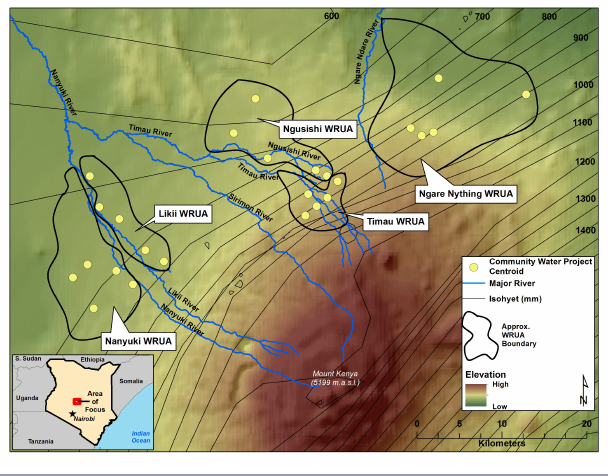
Fig. 1. Study area. Note: WRUA boundaries have been approximated. CWP locations are presented with their centroids. Isohyets represent average yearly precipitation in